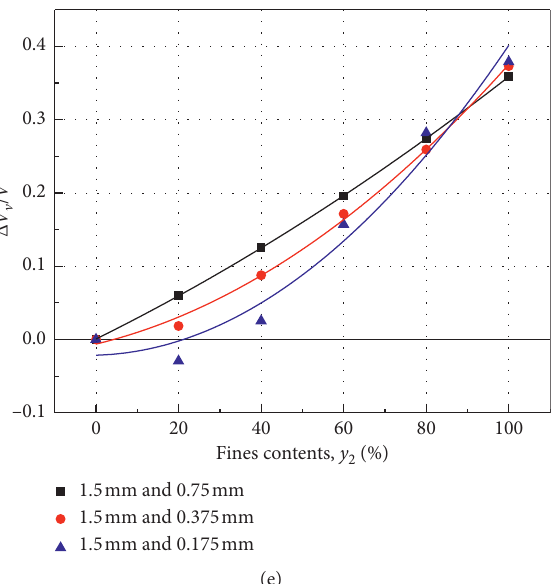
Figure 12: Fitting curves of Δ V